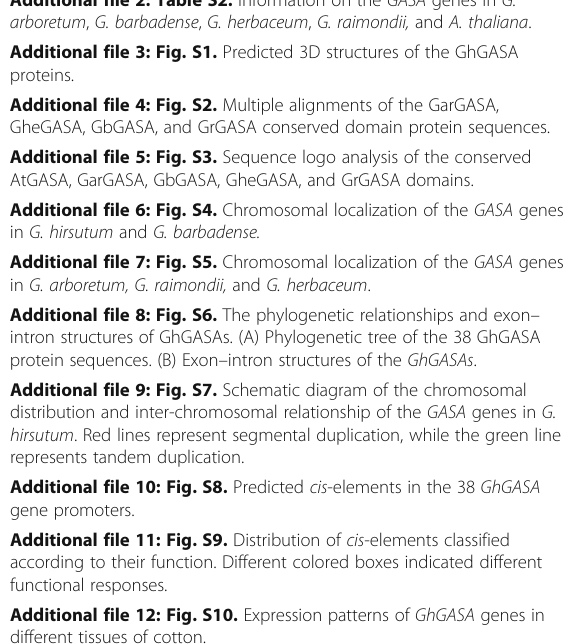
Additional file 2: Table S2. Information on the GASA genes in G. arboretum , G. barbadense , G. herbaceum , G. raimondii, and A. thaliana . Additional file 3: Fig. S1. Predicted 3D structures of the GhGASA proteins.